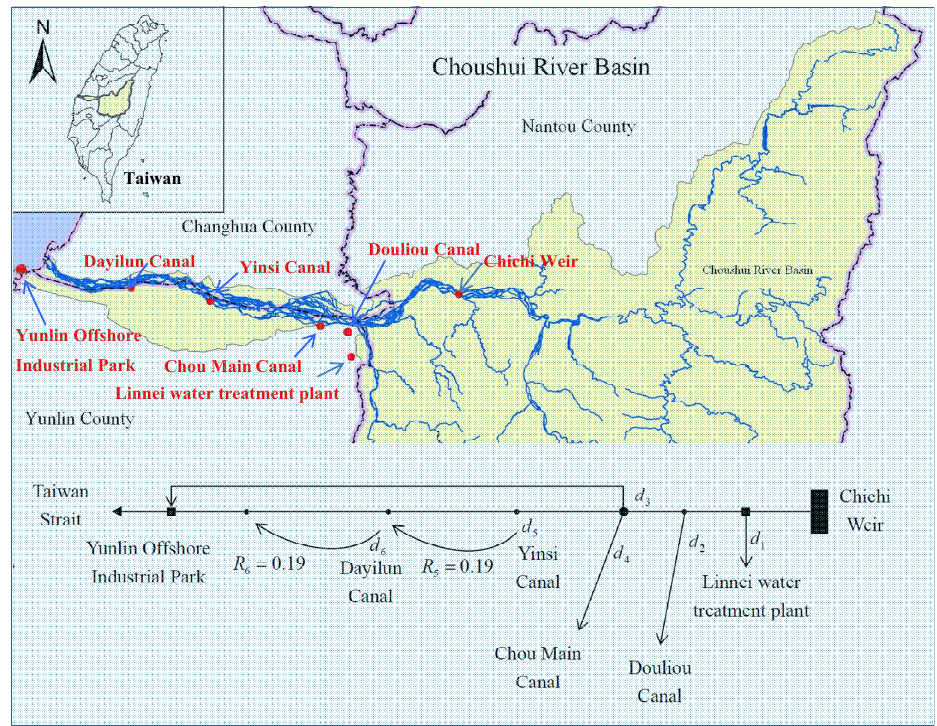
Figure 1. Schematic diagram of the Choushui River